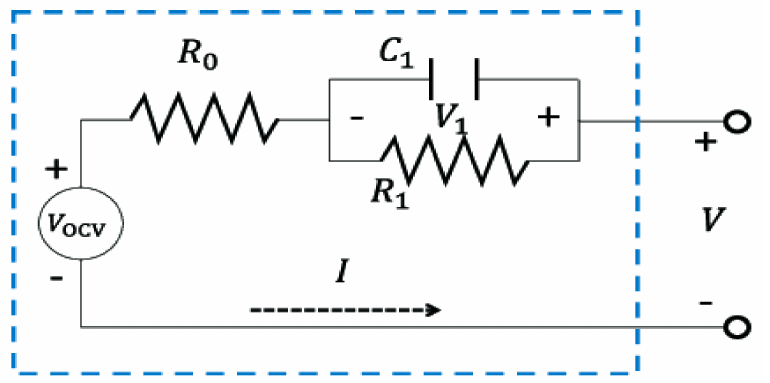
Figure 1. 1-RC ECM (Thevenin’s equivalent) model of an LIB